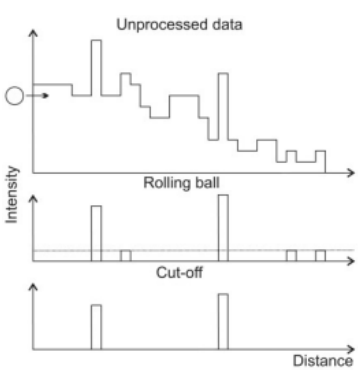
Figure 9. Structure of regions by three-level image